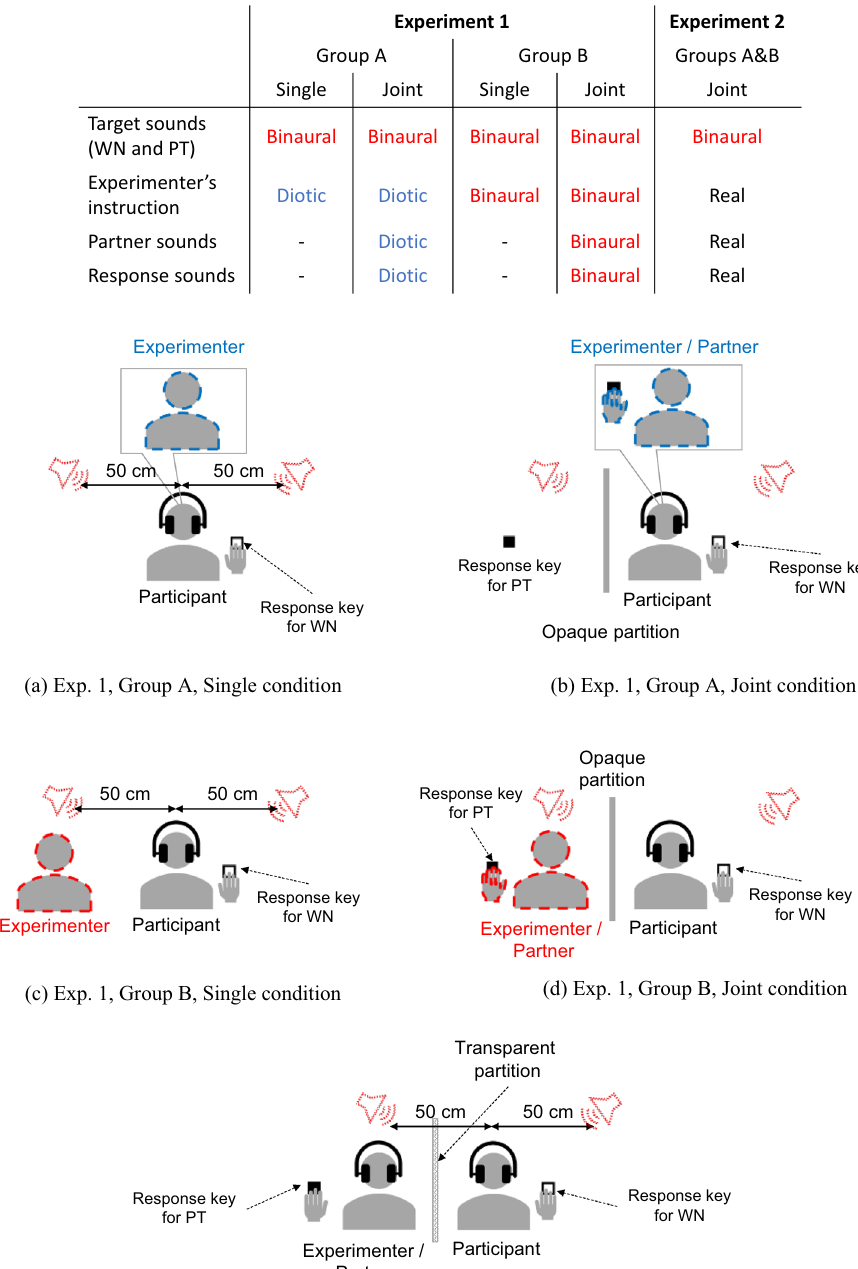
Figure 4. Schematic views of ( a ) Single and ( b ) Joint conditions of Group A in Experiment 1, ( c ) Single and ( d ) Joint conditions of Group B in Experiment 1, and ( e ) Groups A and B (Joint condition only) in Experiment 2. Matrix at the top summarizes the audio conditions. In Experiment 1, target sounds, white noise (WN) and pure tone (PT), were presented binaurally to Group A but the experimenter’s instruction was presented diotically. Partner and response sounds were absent in the Single condition and presented diotically in the Joint condition. In Experiment 1, target sounds and experimenter’s instruction were presented binaurally to Group B. Partner and response sounds were absent in the Single condition and presented binaurally in the Joint condition. Opaque partition was set between the participant and the virtual partner in the Joint condition in Experiment 1. In Experiment 2, an actual partner sat beside the participant. Only target sounds were presented binaurally to both the participant and the partner. Transparent partition was set between the participant and the